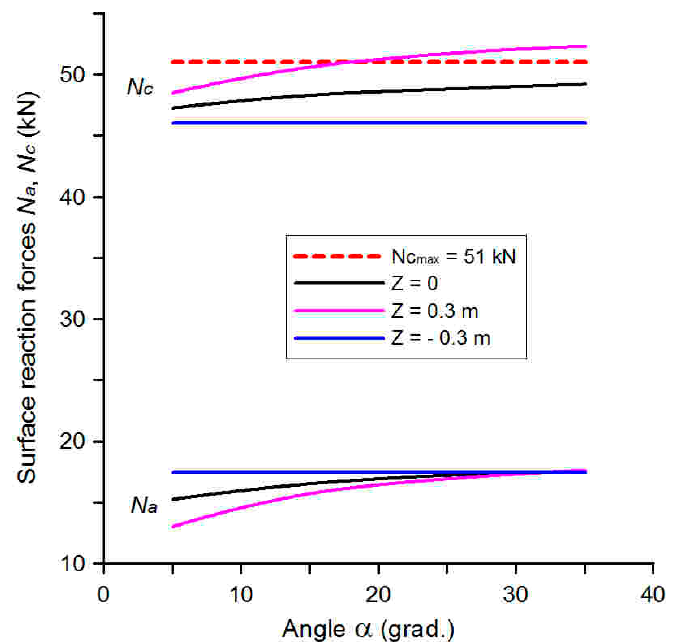
Figure 5. Dependence of forces N a and N c on the angle of installation of the central link of the rear attached mechanism of the tractor α with the installed lower β = 0 ◦